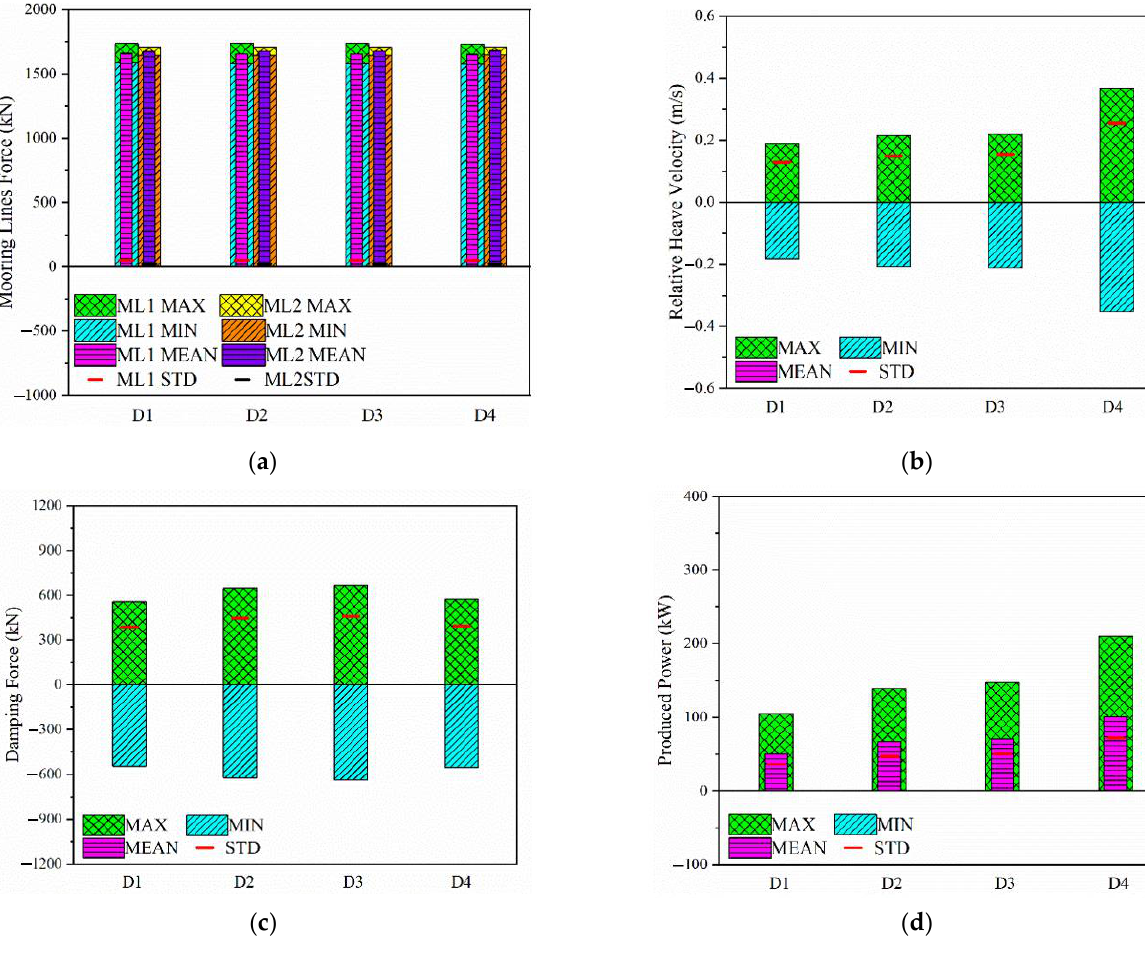
Figure 13. The statistical responses of four different integrated system. ( a ) Mooring Lines force statistics. ( b ) Relative heave velocity statistics. ( c ) Damping force statistics. ( d ) Produced Power statistics.